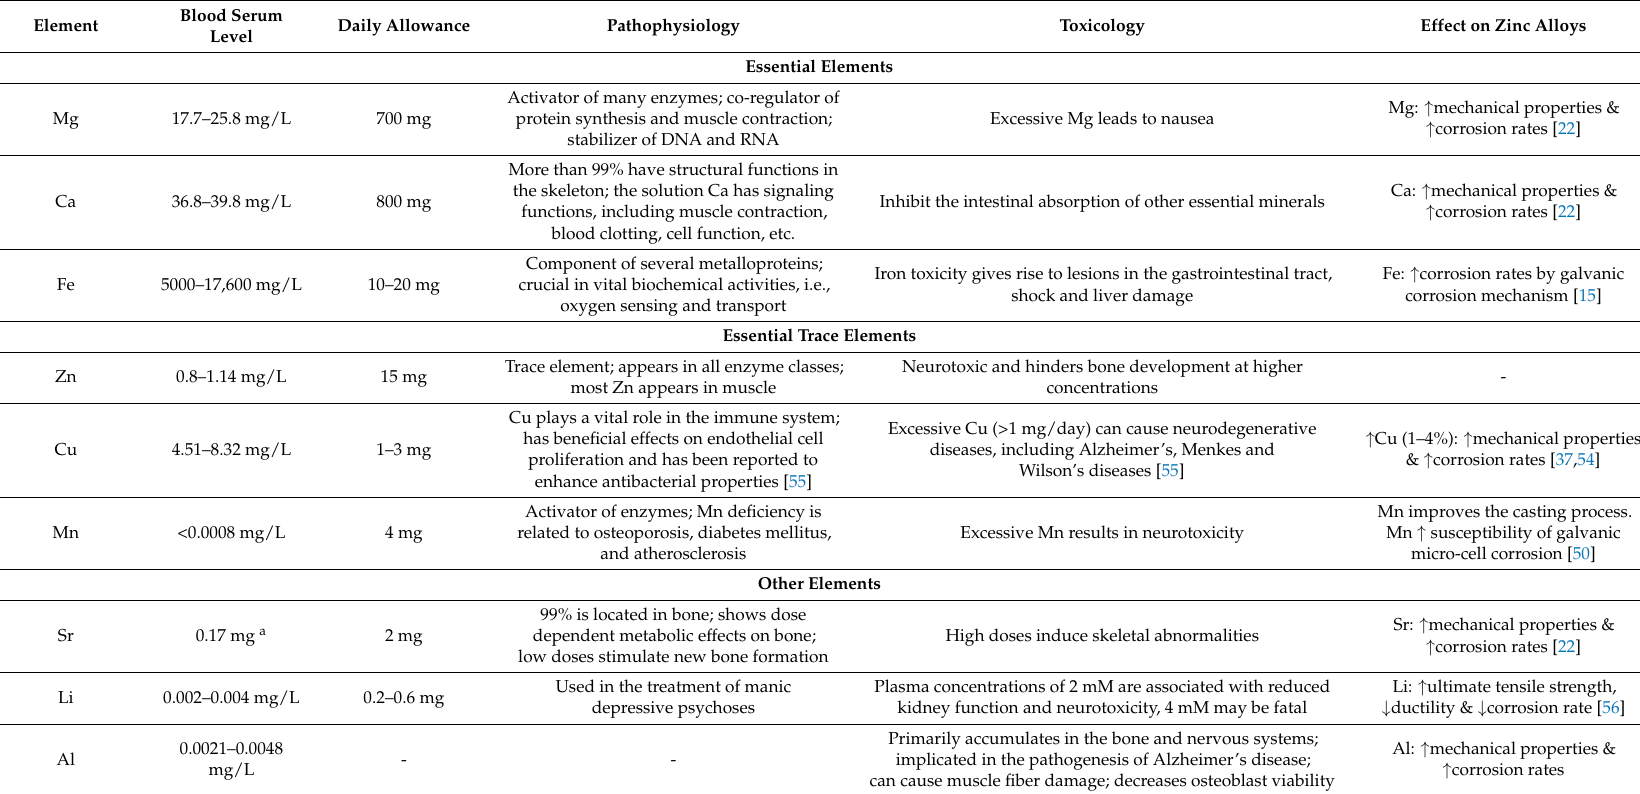
Table 3. Summary of the pathophysiology and toxicology of zinc and select alloying elements [8,10,11,83] and their effect on zinc